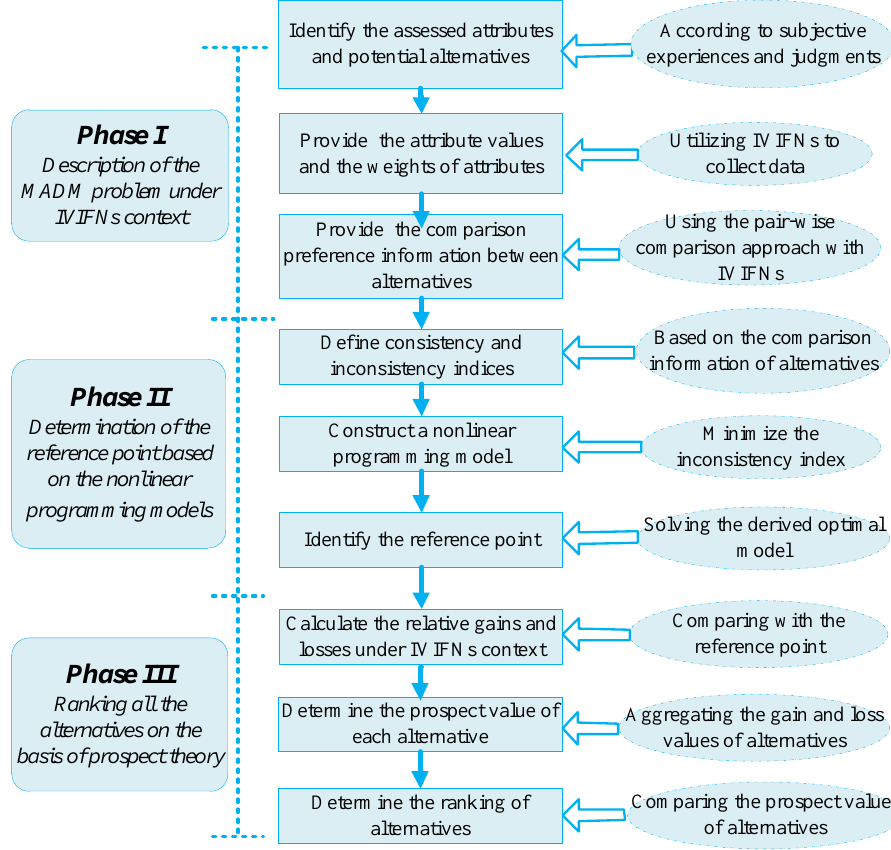
Figure 1. Schematic diagram of the proposed